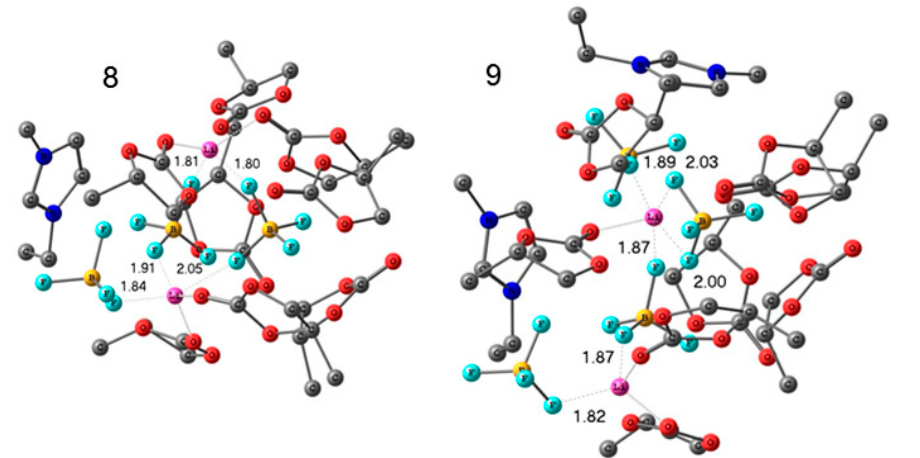
Figure 28. Calculated structures of the solvation complexes with the IL components. Hydrogen atoms are omitted. Interatomic distances are given in Å [128].